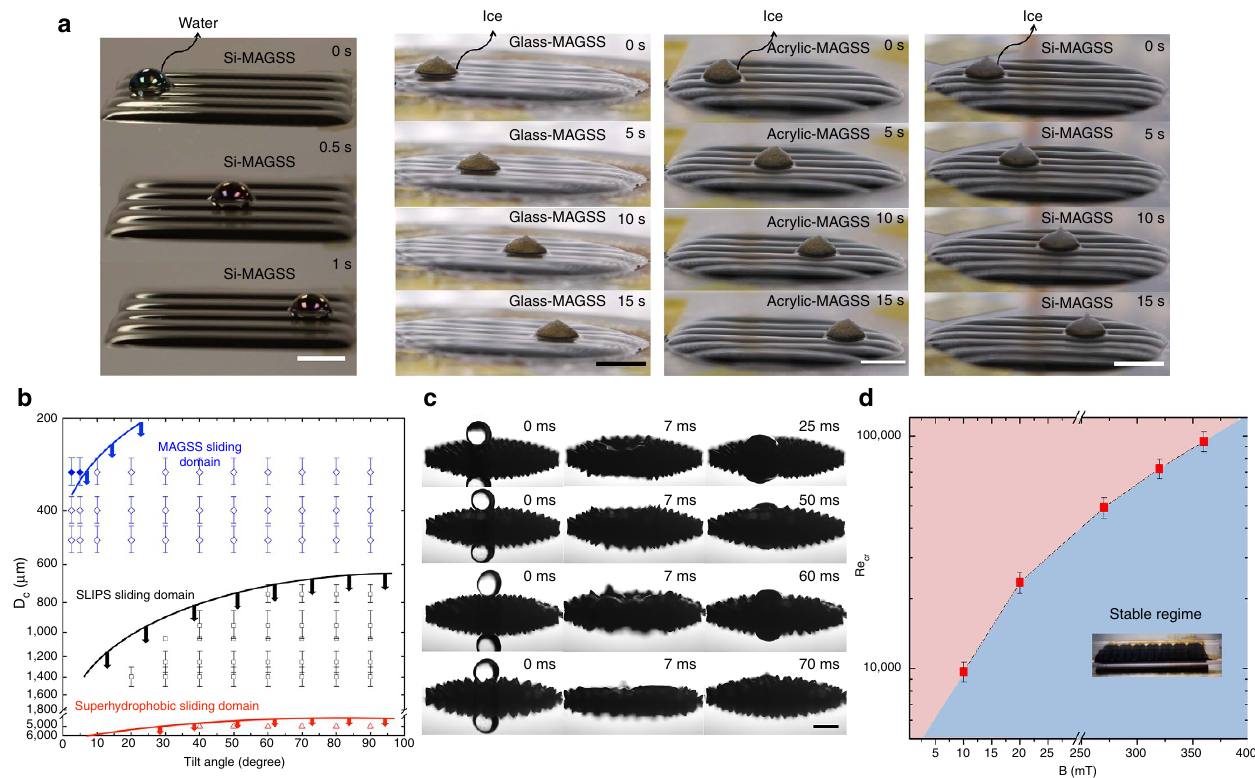
Figure 3 | Characteristics of MAGSS. Surface characteristics of MAGSS, self-healing and stability under high-shear flows are studied. ( a ) The high mobility of a water droplet and ice on MAGSS is shown. For a water droplet with tilt angle of 2.5 (cid:2) , the droplet moves with a velocity of 37.5mms (cid:2) 1 (Supplementary Movies 2–5). For ice with a similar tilt angle, ice has a velocity of 0.8mms (cid:2) 1 . We have shown same mobility of ice with MAGSS developed on glass and acrylic surfaces indicating that mobility is independent of the underlying solid surface. That is, in MAGSS, neither water nor ice experiences any friction by the solid substrate. ( b ) Mobility of the water droplets on MAGSS is examined for different droplet diameters and tilt angles. As shown, MAGSS offers unprecedented mobility compared with other state-of-the-art surfaces. High mobility of droplets on MAGSS reduces the contact time of droplets with the cold surface and hinders possibility of ice nucleation. The error bars represent uncertainty in the experimental approach. ( c ) The self-healing characteristics of MAGSS is assessed through droplet impact experiments. At t ¼ 0ms, the droplet is just about to impact the surface. At t ¼ 7ms, the perturbation of the surface is evident and as the impact velocity is increased, so does the amount of perturbation. The last image in the sequence shows the completely healed MAGSS. MAGSS has revived its structure in o 70ms with no sign of splashing or depletion of ferrofluid. The Weber numbers are 18.87, 30.78, 71.82 and 154.68, respectively (Supplementary Movie 6). For higher Weber numbers (600), we used high viscosity ferrofluid and no change in the characteristics of the surface was observed (Supplementary Video 7). ( d ) Stability of MAGSS under an imposed high-Reynolds number shear flow is shown. Critical Reynolds number is a function of the magnetic field. The assumed critical threshold was depletion rate ( r 2 m m per hour) of ferrofluid from the surface. At higher magnetic fields, MAGSS is stable up to a Reynolds number of 10 5 . (Supplementary Movies 9 and 10). We ran these experiments for more than 15h to examine longevity of these surfaces. Scale bar,